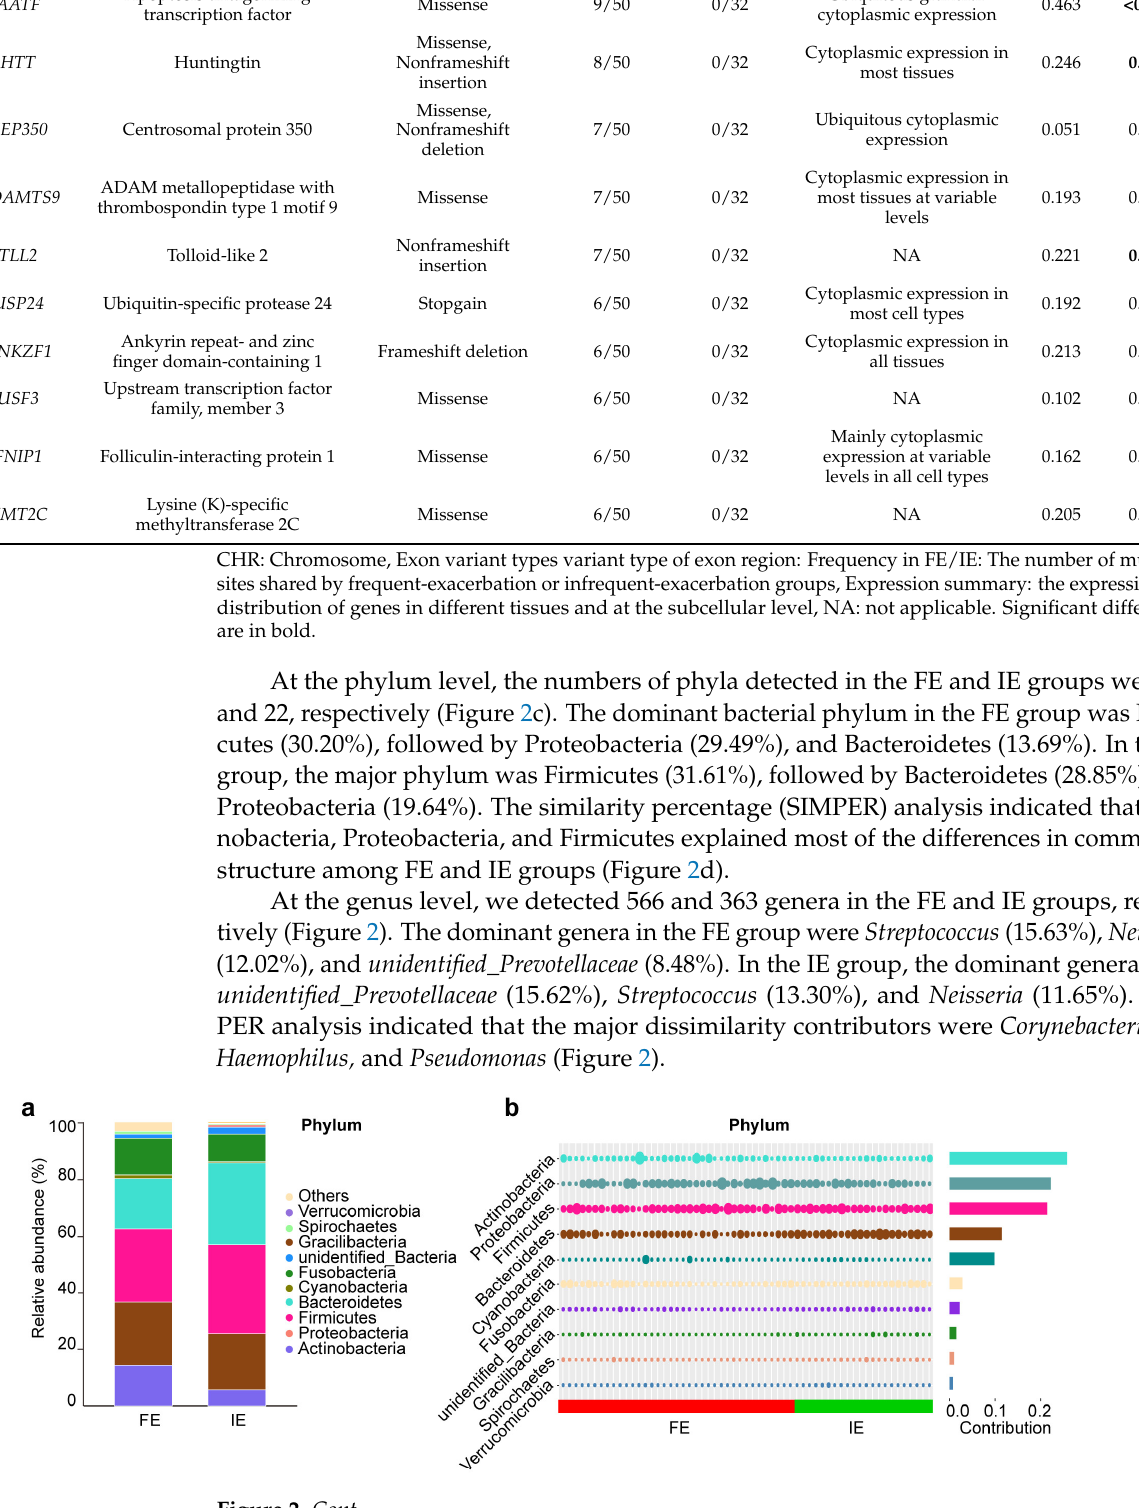
Figure 2. Bacterial community structure in FE (n = 37) and IE (n = 22) group. Relative abundance and Simper analysis of the most prevalent bacteria and at the phylum ( a , b ) and genus levels ( c , d ) in FE and IE group. The bubble size represents the relative abundance of the species, and the contri- bution represents the contribution of the species in the two groups of differences. FE frequent exac- erbator, IE infrequent exacerbator. At the genus level, we detected 566 and 363 genera in the FE and IE groups, respec- tively (Figure 2). The dominant genera in the FE group were Streptococcus (15.63%), Neis- seria (12.02%), and unidentified_Prevotellaceae (8.48%). In the IE group, the dominant genera were unidentified_Prevotellaceae (15.62%), Streptococcus (13.30%), and Neisseria (11.65%). SIMPER analysis indicated that the major dissimilarity contributors were Corynebacteri- aceae , Haemophilus, and Pseudomonas (Figure 2).